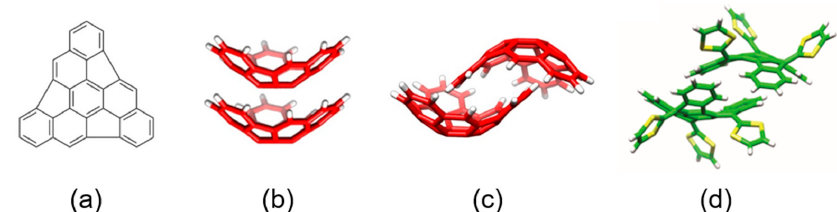
Figure 15. Chemical structure of the hemifullerene C 30 H 12 buckybowl ( a ); Structure of the dimers formed by C 30 H 12 (carbon atoms in red) in its trigonal ( b ) and orthorhombic ( c ) crystal polymorphs, respectively; ( d ) Dimers formed by truxTTF in the crystal. For C 30 H 12 , the carbon atoms are depicted in red and hydrogen atoms in white. For truxTTF, the sulfur, carbon and hydrogen atoms are colored in yellow, green and white,